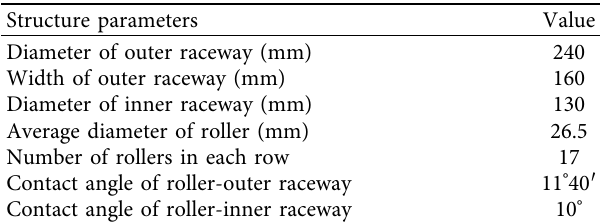
Figure 6: Double-row tapered roller bearing. Table 2: Structure parameters of axle-box